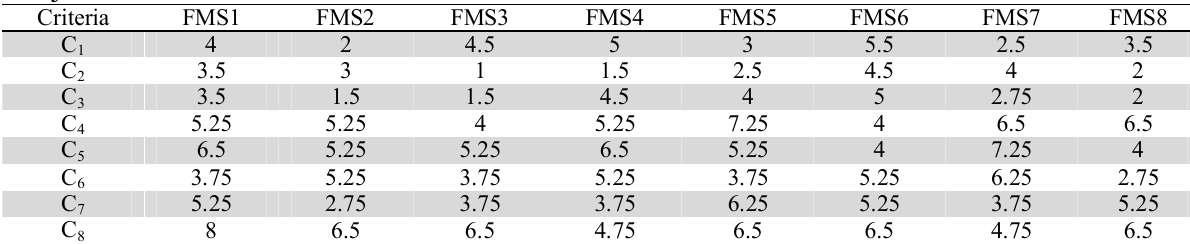
Projection distances of FMS alternatives in ORESTE method